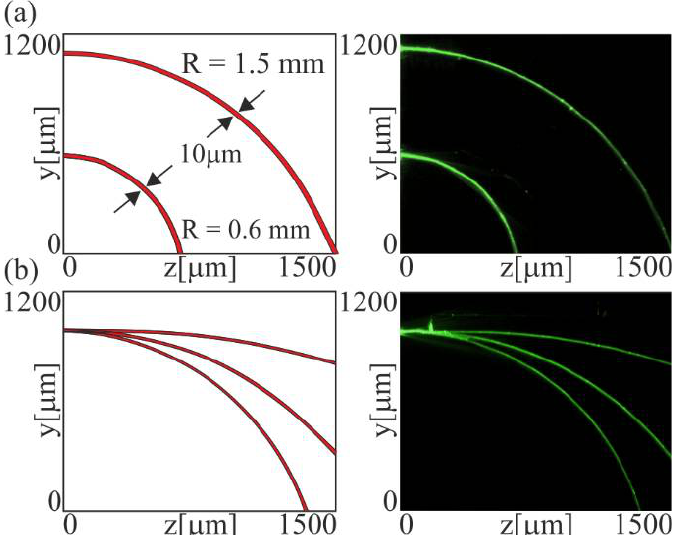
Figure 4. ( a ) Scheme of the curved geometry of the electrodes in NLC cell (left panel) and λ = 532 nm, TM-polarized beam propagation (right panel). ( b ) Combined three arch-shaped electrodes (left panel) and TM-polarized beam propagation at λ = 532 nm for U = 2.3 V.